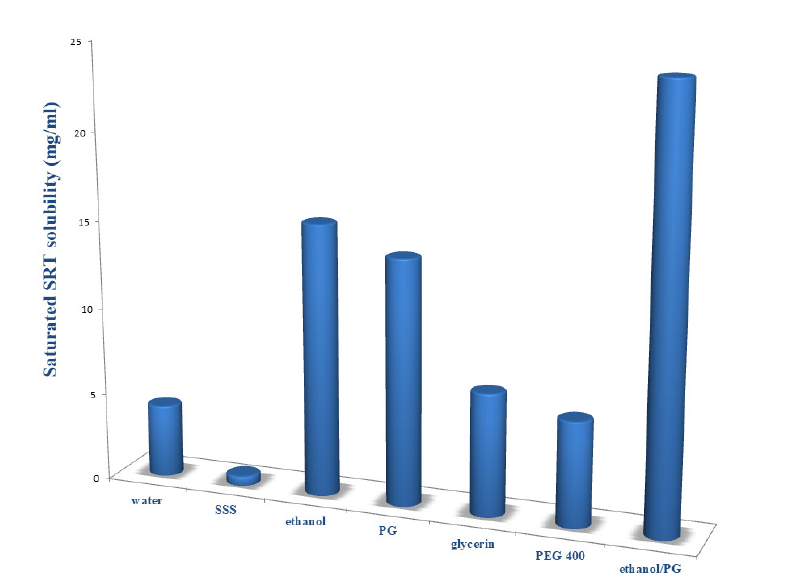
FIGURE 2 - Saturated solubility of SRT in different media and